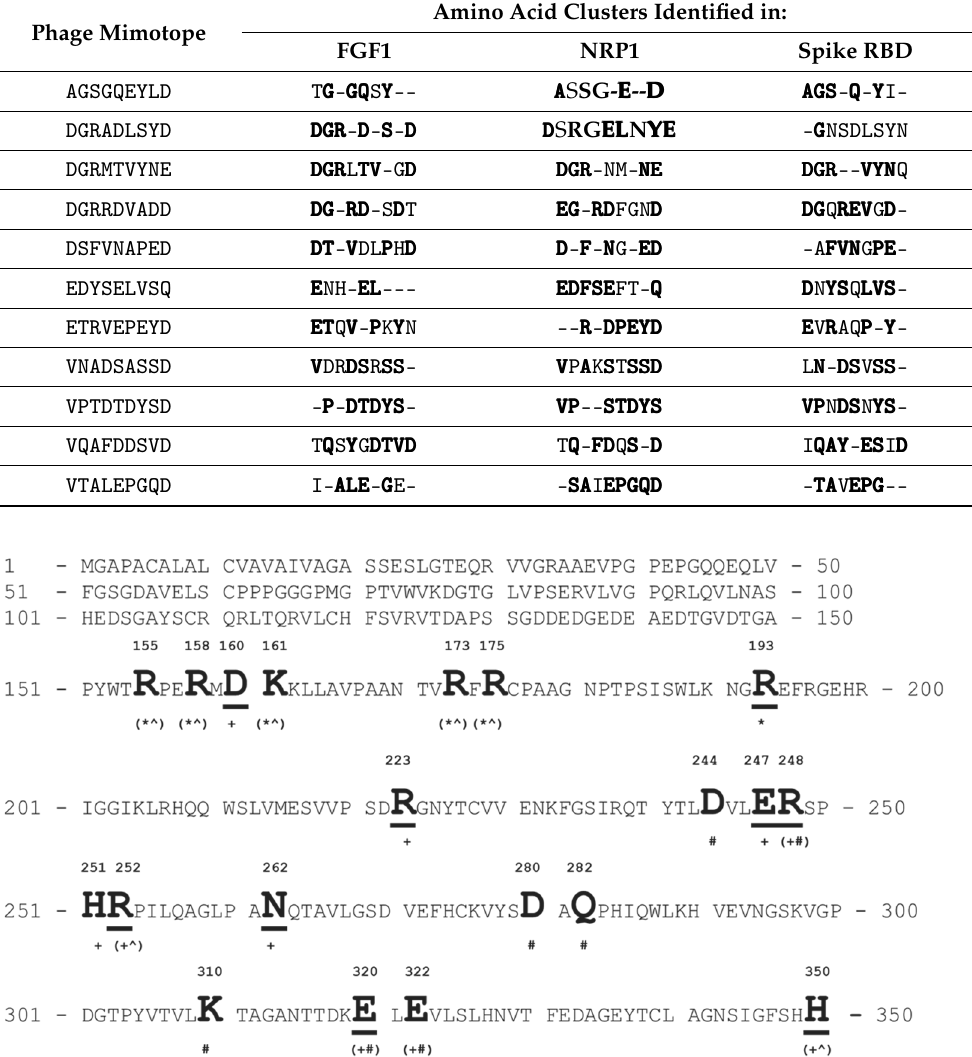
Table 2. Amino acid clusters identified on the surface of ligands and their corresponding phage mimotopes. Bold letters highlight the amino acid residues shared with the phage mimotope.